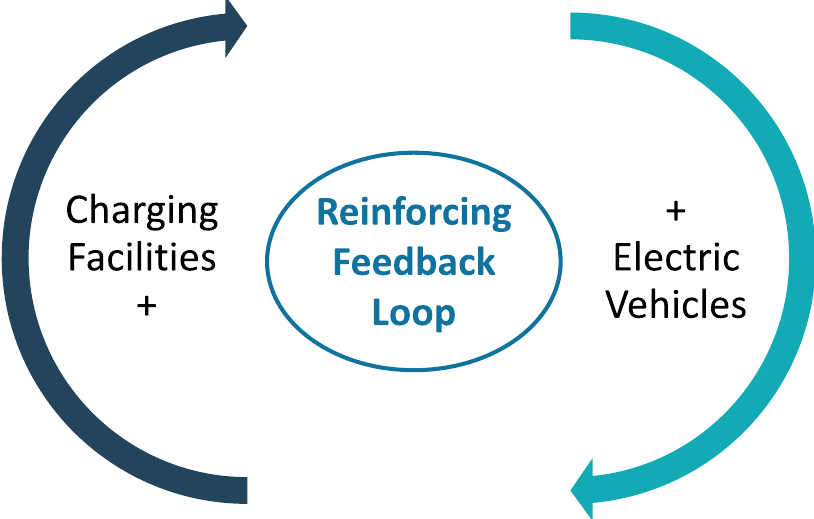
Figure 1. Feedback loop between EV uptake and charging facilities